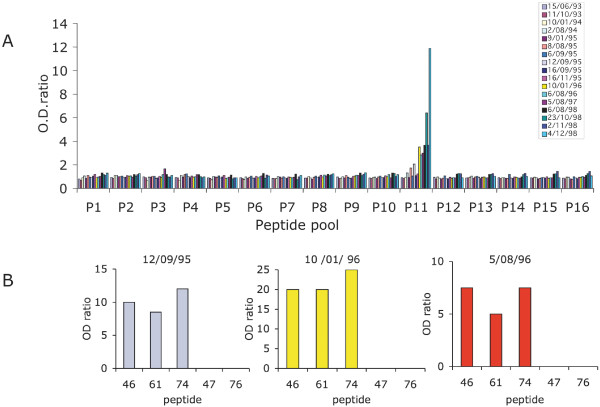
Serological longitudinal follow up of child 01/13 from 6 months to 6 years of age. Antibodies were assayed on 16 pools of biotinylated peptides (A) and to each individual peptide from positive pool 11 (B). The peptide sequence and composition of the pools are described in Table 5. The dates of blood sampling are shown to the right of the graph. A. reactivity on the peptide pool. B. reactivity of three representative blood samples on individual peptides from pool 11.